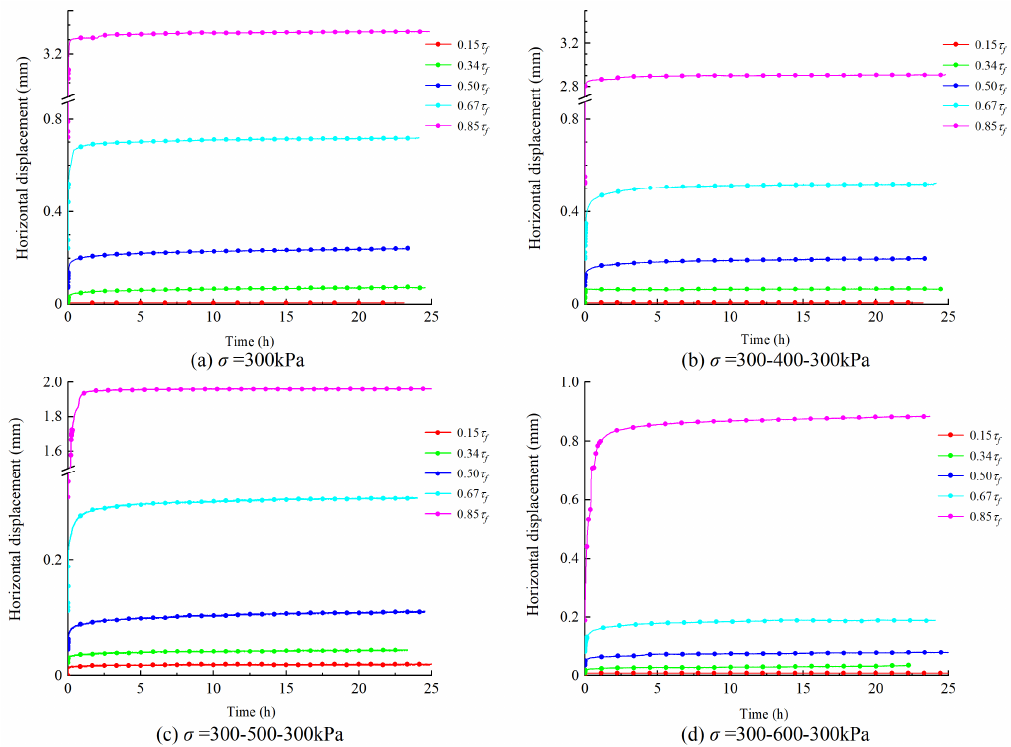
Figure 8. Horizontal displacement curves of sliding zone soil with different consolidation paths according to the Boltzmann superposition principle.